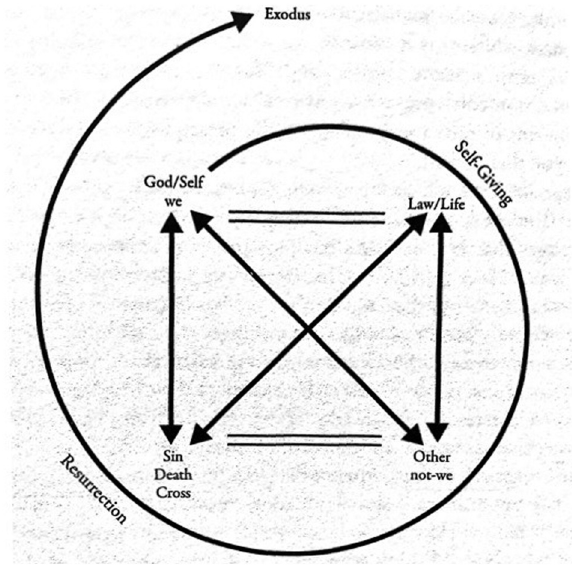
Figure 1: “ Exodus and Messianic Dissolution of the Combat Order, ” in Kahl, Galatians Re - imagined , 264. A movement of which “ love ” ( ἀ γάπη rather than ἔ ρως ) is the “ driving power that throws the combat square into an irreversible spin of messianic ‘ revolution; ’” ¹ ⁵⁹ or, in other words, into “ a metamorphosis that does not simply replace one empire with another empire, the kingdom of Caesar with a counter - kingdom of God, ” ¹ ⁶⁰ but brings “ the perpetual war of civilization, ” i.e. the fi ght of the One against the Many, to a “ halt ” by means of a “ messianic revolution ” ¹ ⁶ ¹ which turns the Many into an even - more - powerful One . The crucial point is the premise on which the whole κήρυγμα stands: Paul ’ s dismissal of any ἀ ρχή ,